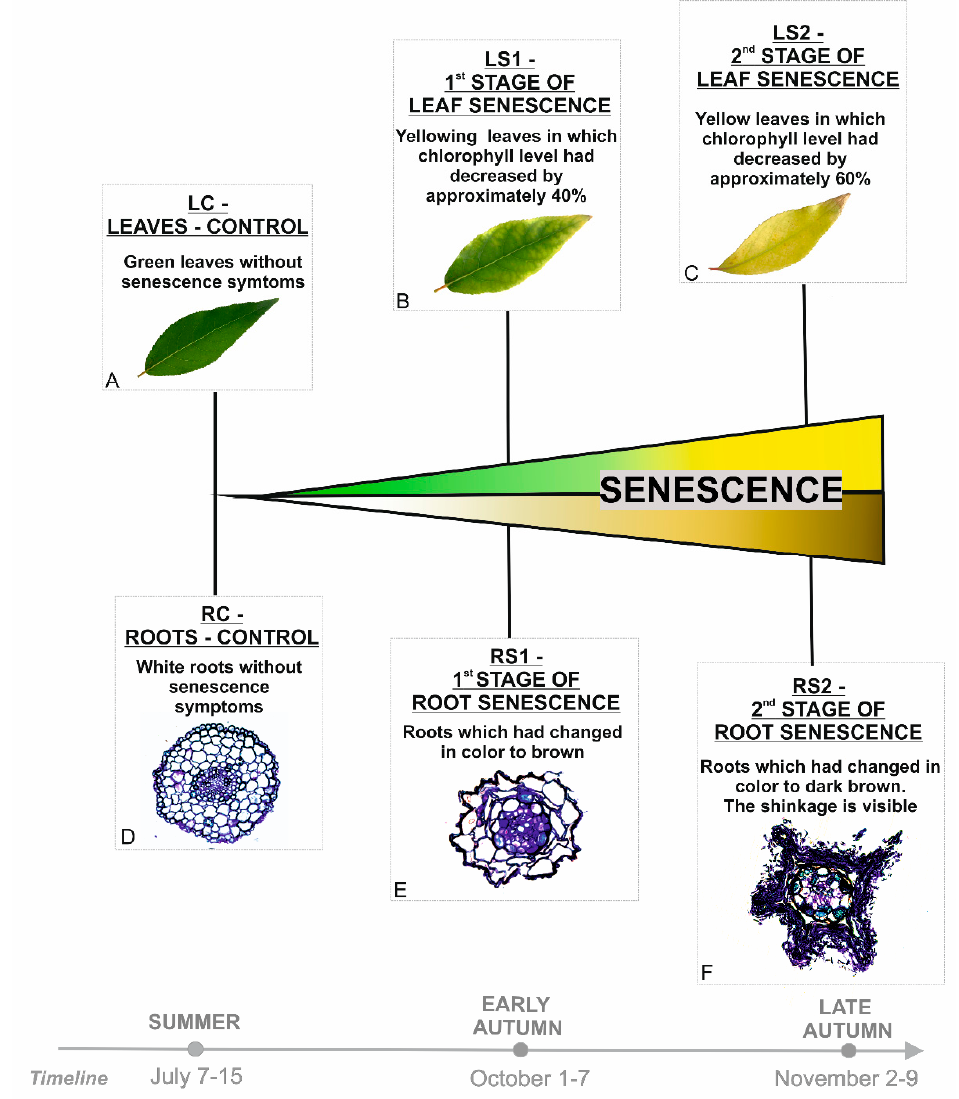
Figure 1. Stages of leaves ( A – C ) and fine, absorptive roots ( D – F ) selected for analyses based on morphological and anatomical changes observed during the vegetative season.